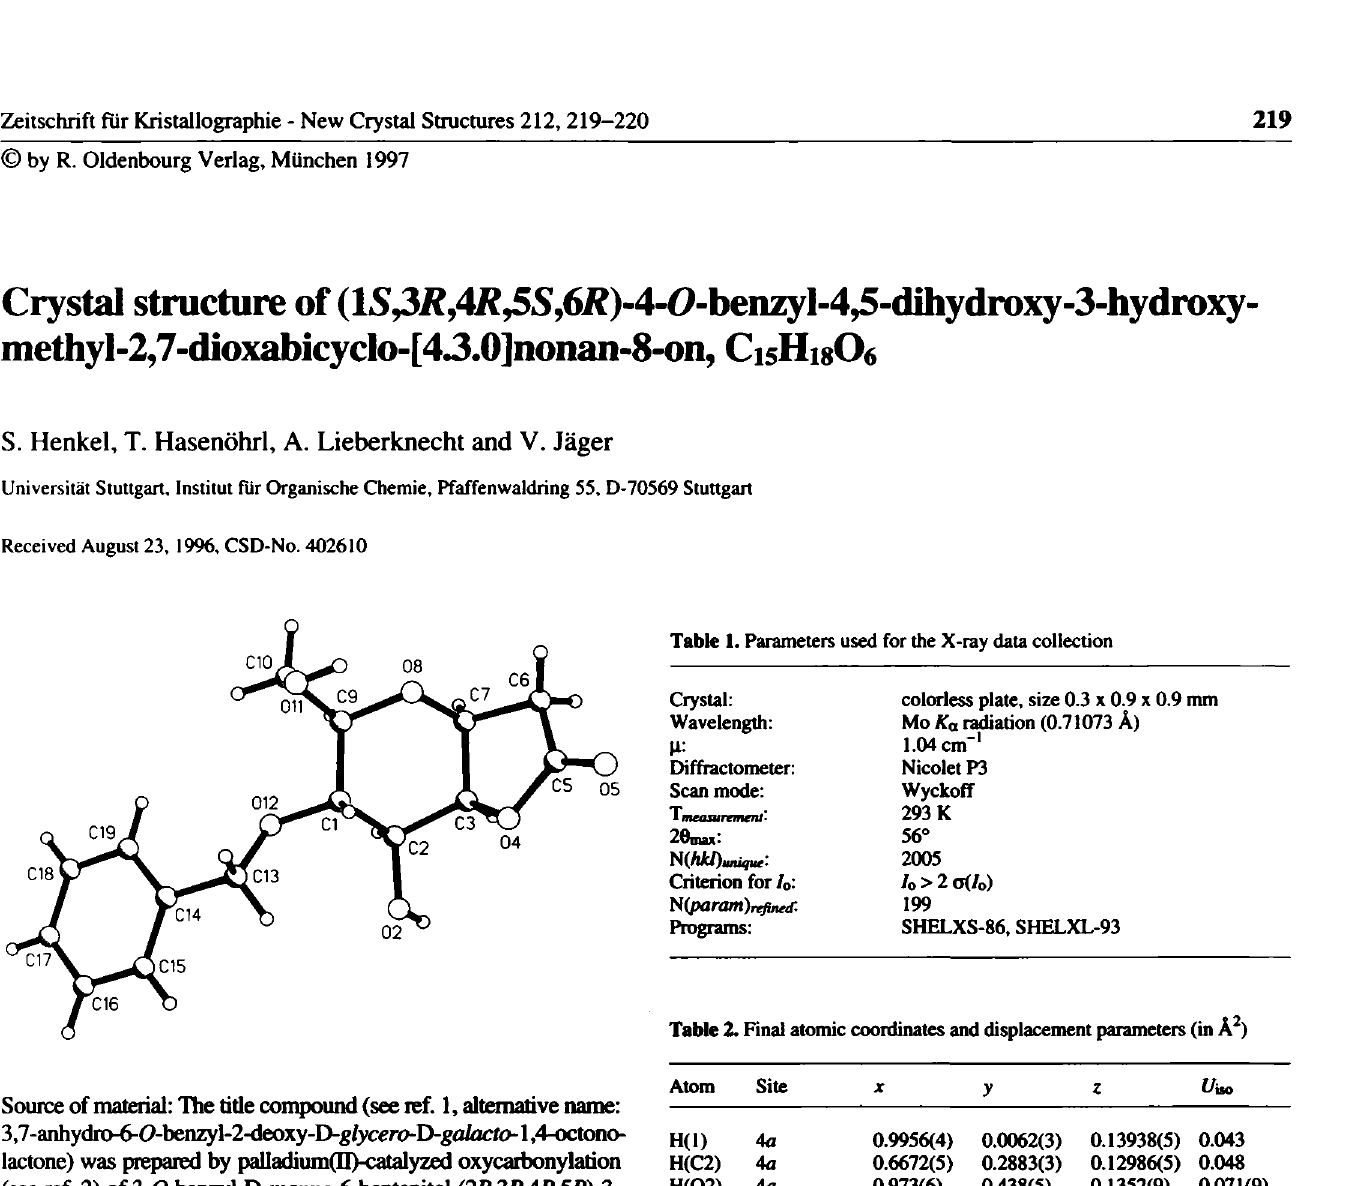
Table 2. Final atomic coordinates and displacement parameters (in Â 2 )